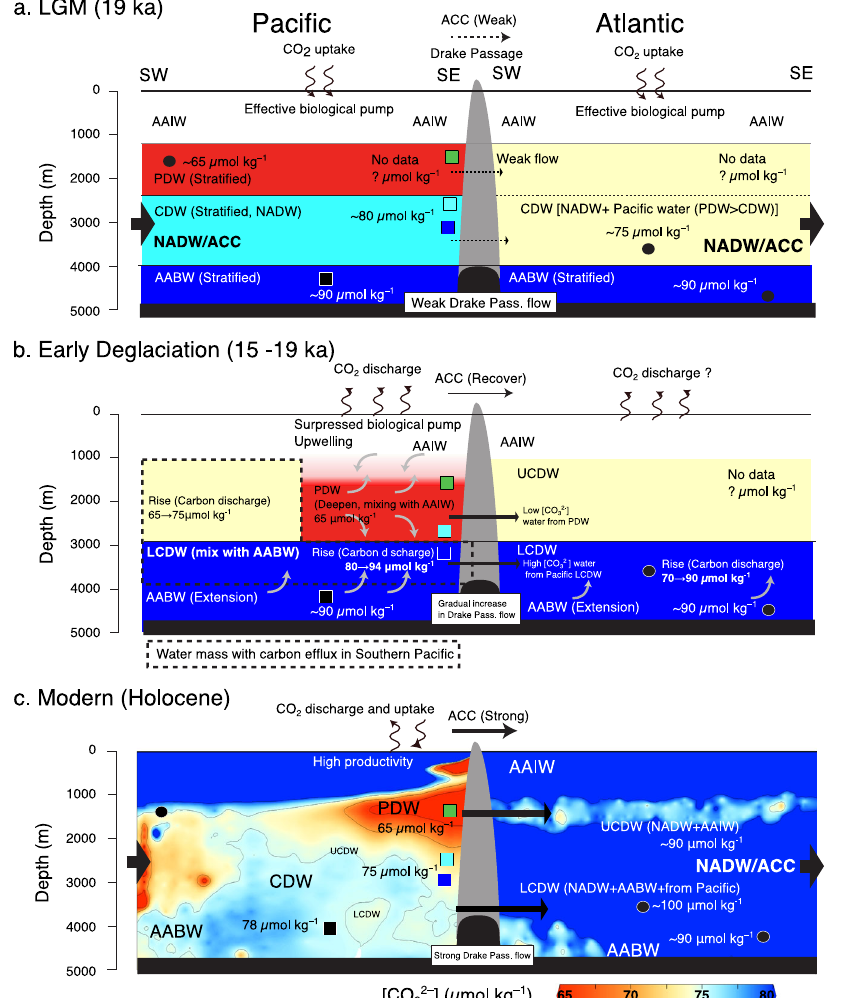
Fig.6|SchematicillustrationofwatercolumnstructureintheSouthernPaci fi c and the Southern Atlantic at the end of LGM, the early deglacial, and Modern condition. a LGM (Last Glacial Maximum, 19 ka BP): characterized by strong deep- waterstrati fi cation,weakAntarcticCircumpolarCurrent(ACC),weakDrakePassage fl ow, and strong Atlantic meridional overturning circulation (AMOC). b The